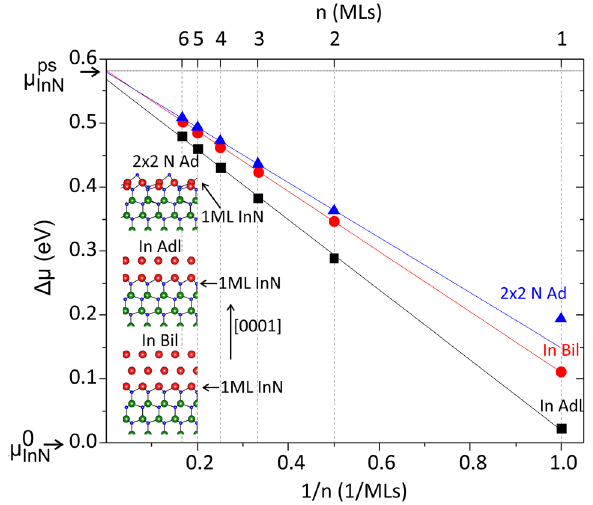
Figure 6. Chemical potential of InN epilayers on (0001) GaN with respect to the chemical potential of relaxed InN, �µ , as a function of the number of MLs, n . Three different surface terminations/growth conditions are considered: 2 × 2 N adatom reconstruction under N-rich conditions (2 × 2 N Ad), indium adlayer under moderate In-rich conditions (In Adl), and indium bilayer under In-rich conditions (In Bil). The chemical potentials of relaxed InN and InN biaxially strained to GaN are denoted as µ lines are linear fits to data of the four thicker InN layers. Inset: Cross sectional schematic representations of the respective surface morphologies. The coloring of atoms in the ball-and-stick models is as in Fig.